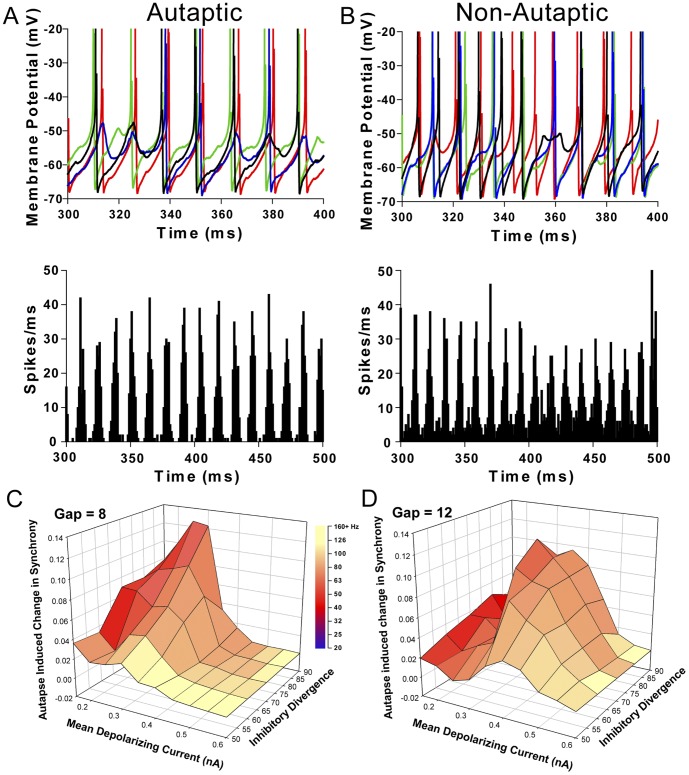
Autapses enhance cell synchrony in a model of gamma oscillations.
A. A representative run showing network behavior when cells are equipped with autapses. The network has a mean depolarizing current of 300: Membrane potential oscillations in 4 cells (50 cells apart) showing synchronous firing and subthreshold membrane potential oscillations. Lower panel: A histogram including the same time period as the upper panel showing action potentials over the last 200 ms of the simulation over all cells. This simulation run has a synchrony score of 0.14. B. Network behavior in a non-autaptic model. The network has the same properties as A, but without the presence of autapses. Upper panel: Membrane potential oscillations in 4 cells (50 cells apart) showing a lower level synchronous firing and subthreshold membrane potential oscillations. Lower panel: A histogram including the same time period as the upper panel showing action potentials over the last 200 ms of the simulation over all cells. This simulation run has a synchrony score of 0.09. C
. The change in synchrony produced by the presence of autapses in a network with a gap junctional coupling of 8. The color shows the frequency of the network oscillation D. When the maximum number of cells each neuron can contact is increased to 12, the area of parameter space where autapses can enhance synchrony is reduced, however the maximum enhancement is unchanged.